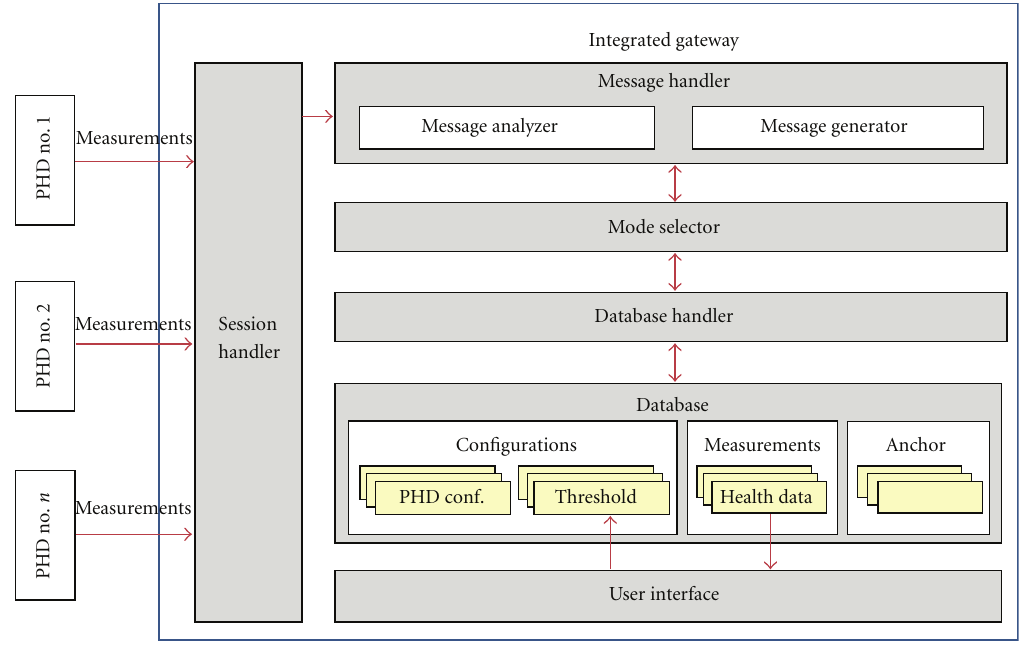
Figure 3: Architecture of an integrated